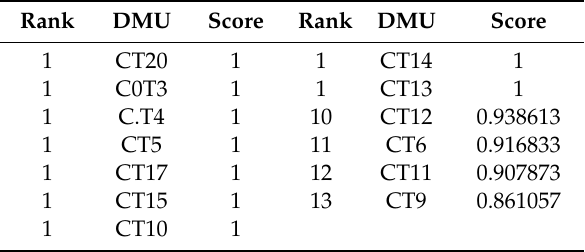
Table 5. E ffi ciency scores and ranking for second